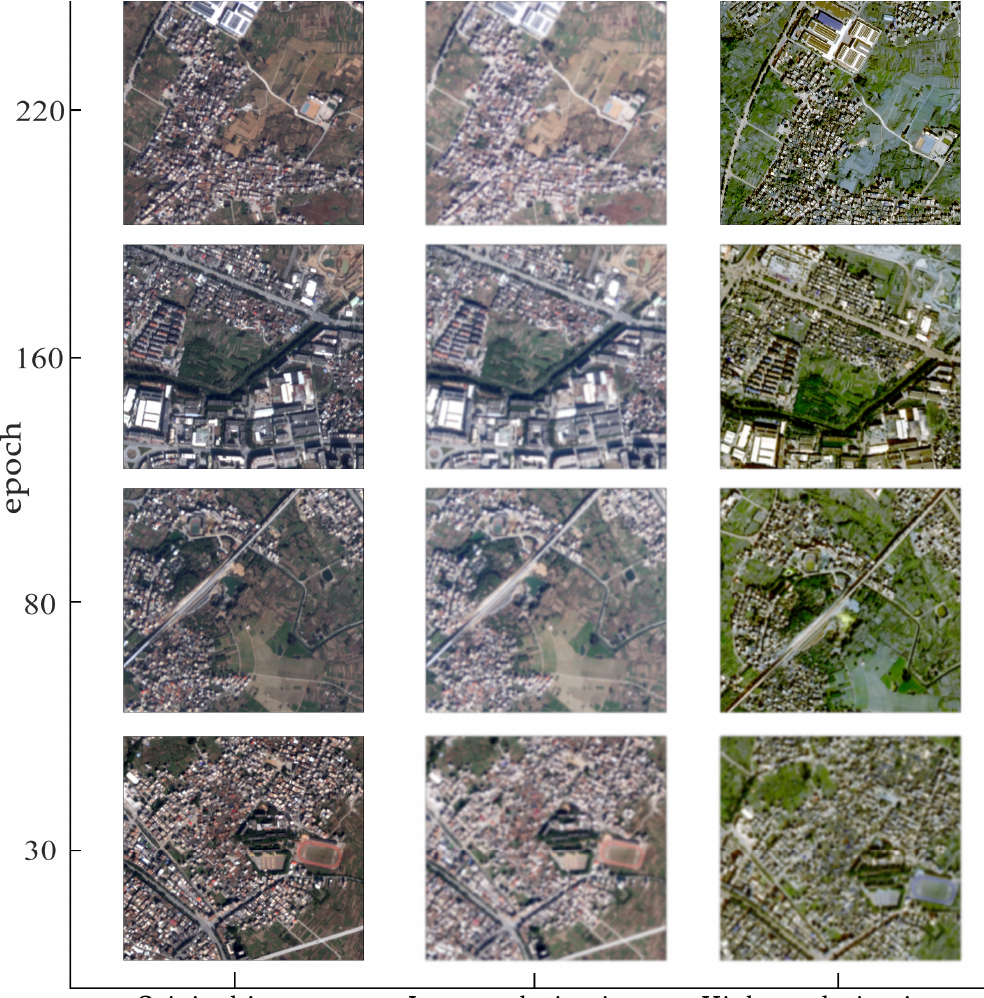
Figure 10. Superpixel reconstruction of training sample change.